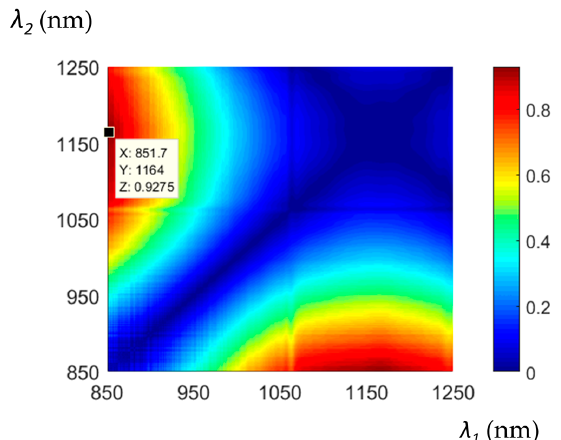
Figure 10. Absolute value of the sensitivity matrix determinant D for different wavelength pairs. Data cursor shows the optimized choice of wavelengths.